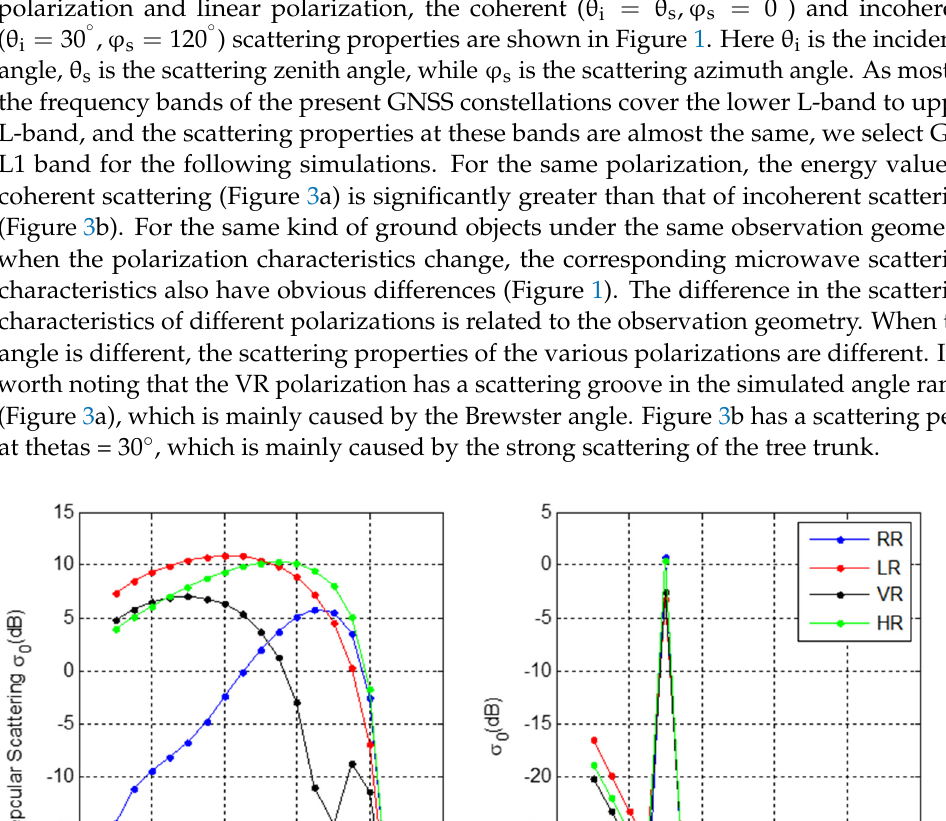
Figure 4. Comparison between coherent and incoherent scattering ( a ) RR polarization, ( b ) LR po- larization, ( c ) VR polarization, and ( d ) HR polarization. 4.4. The Influence of Observation Geometry on Scattering Characteristics Figure 3a shows the relationship between the scattering characteristics and the spec- ular scattering angle, and Figure 3b shows the relationship between the scattering charac- teristics and the scattering zenith angle, while the incident angle ( θ (cid:2919) = 30 ° ) and scattering azimuth angle ( φ (cid:2929) = 120 ° ) are fixed. It can be seen that in different observation geome- tries, the scattering characteristics corresponding to various polarizations are obviously different. Figure 4 shows that in various polarizations, the scattering difference